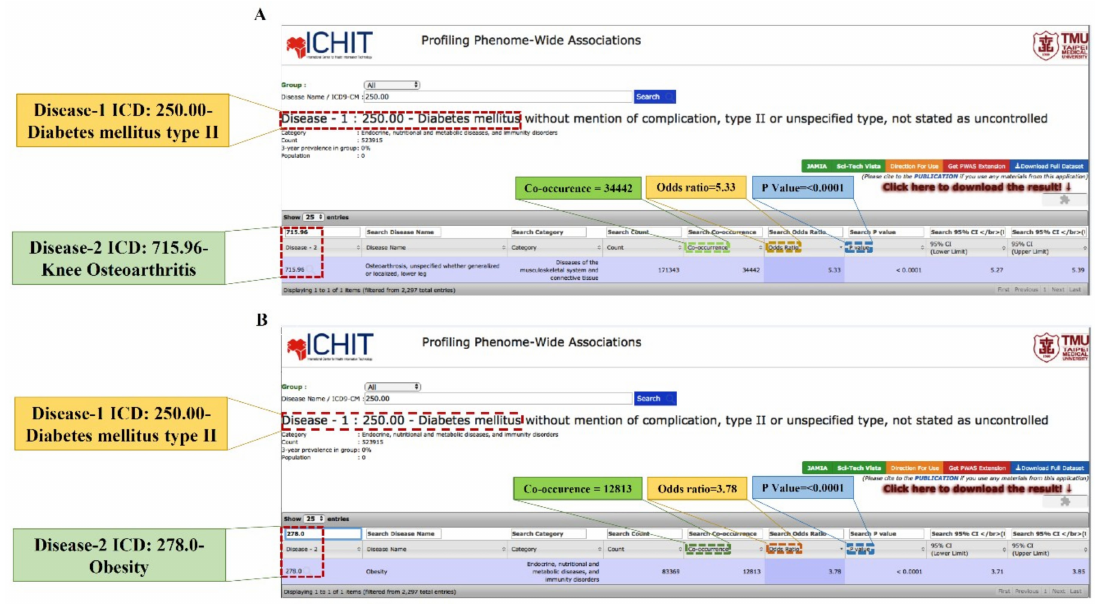
Figure 4. Screenshot of the PWAS portal displaying the association between ( A ) T2DM and KOA and ( B ) T2DM and obesity. DM: Diabetes mellitus, T2DM: Type 2 diabetes mellitus, KOA: Knee osteoarthritis, and PWAS: Phenome-wide association